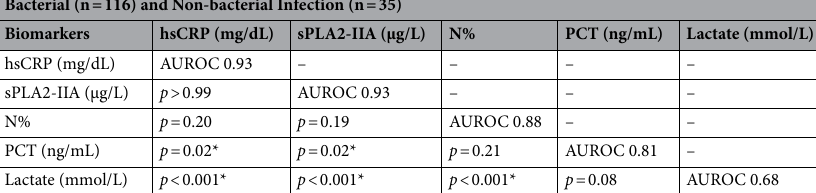
Bacterial (n = 116) and Non-bacterial Infection (n =